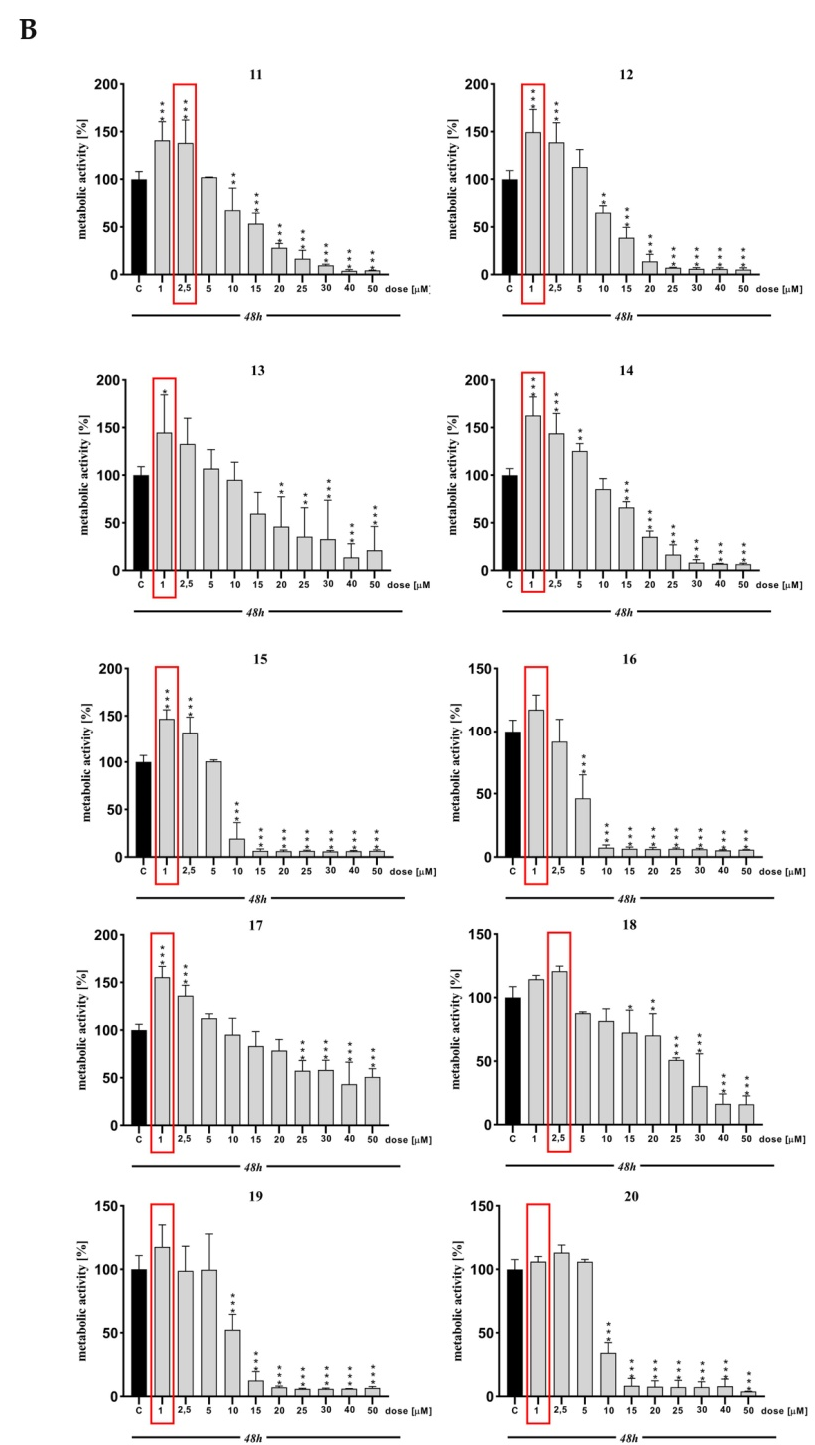
Figure 2. ( A ). Metabolic activity of HT-22 cells treated with compounds 1 – 10 for 48 h. All experimental groups were compared using one-way ANOVA of variance with Dunnett’s post hoc test; mean ± SD, n = 9. Statistically significant results are displayed as: * p < 0.05; ** p < 0.01; *** p < 0.001. ( B ) Metabolic activity of HT-22 cells treated with compounds 11 – 20 for 48 h. All experimental groups were compared using one-way ANOVA of variance with Dunnett’s post hoc test; mean ± SD, n = 9. Statistically significant results are displayed as: * p < 0.05; ** p < 0.01; *** p < 0.001.